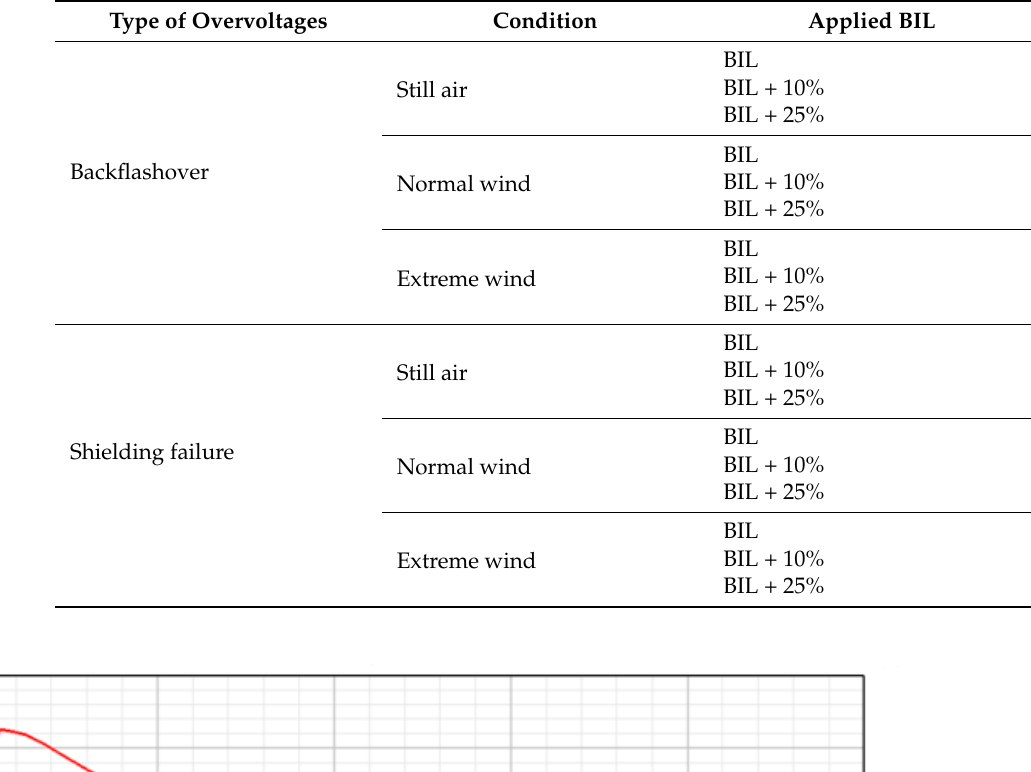
Table 9. Various simulations cases study.